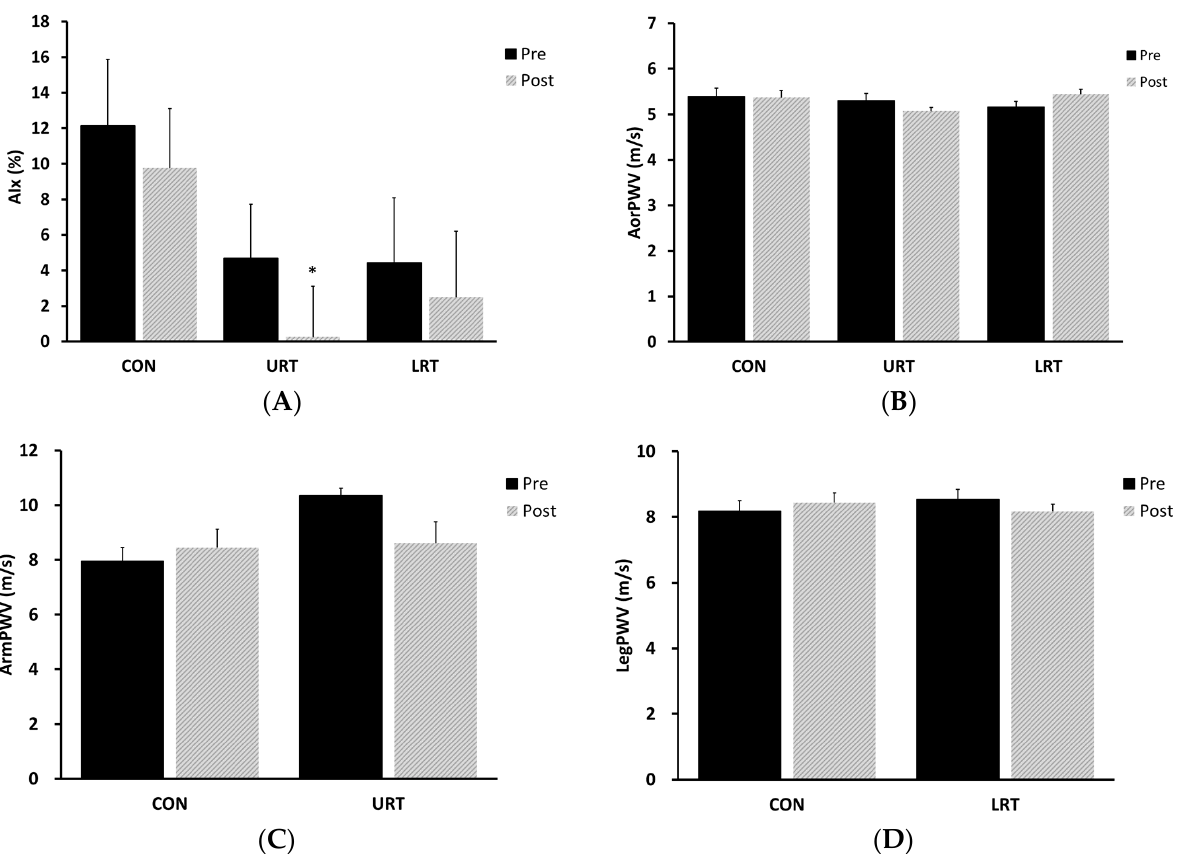
Figure 1. Change in central (AIx and AorPWV, panels ( A ) and ( B ), respectively) and peripheral (ArmPWV and LegPWV, panels ( C ) and ( D ), respectively) artery stiffness in response to the intervention. AIx, augmentation index; AorPWV, aortic (carotid–femoral artery) pulse wave velocity; ArmPWV, arm (brachial–radial artery) pulse wave velocity, LegPWV, leg (femoral–posterior tibial artery) pulse wave velocity; CON, nontraining control group; URT, upper-limb resistance training group; LRT, lower-limb resistance training group.